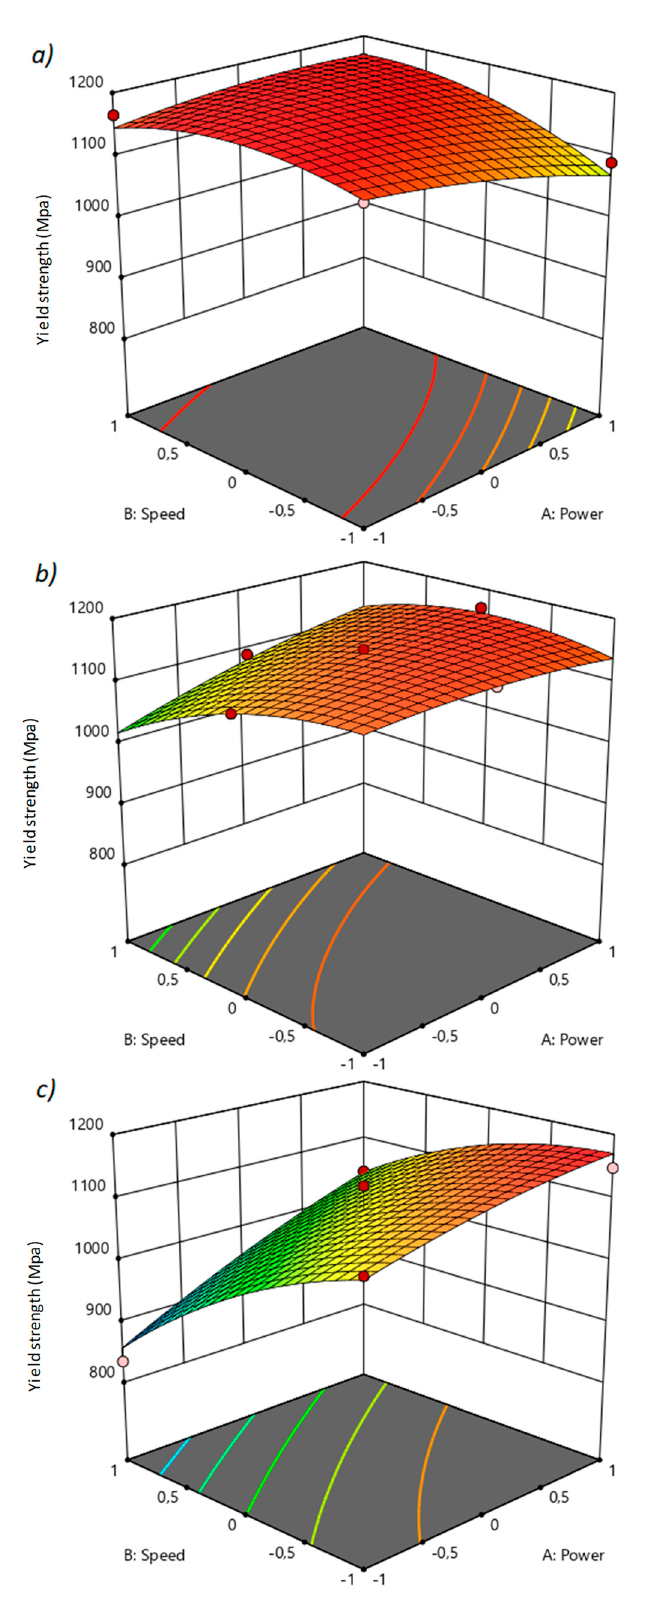
Figure 9. Response surfaces for σ 0.2 , ( a ) H ∗ = − 1 ( b ) H ∗ = 0 ( c ) H ∗ = 1 .